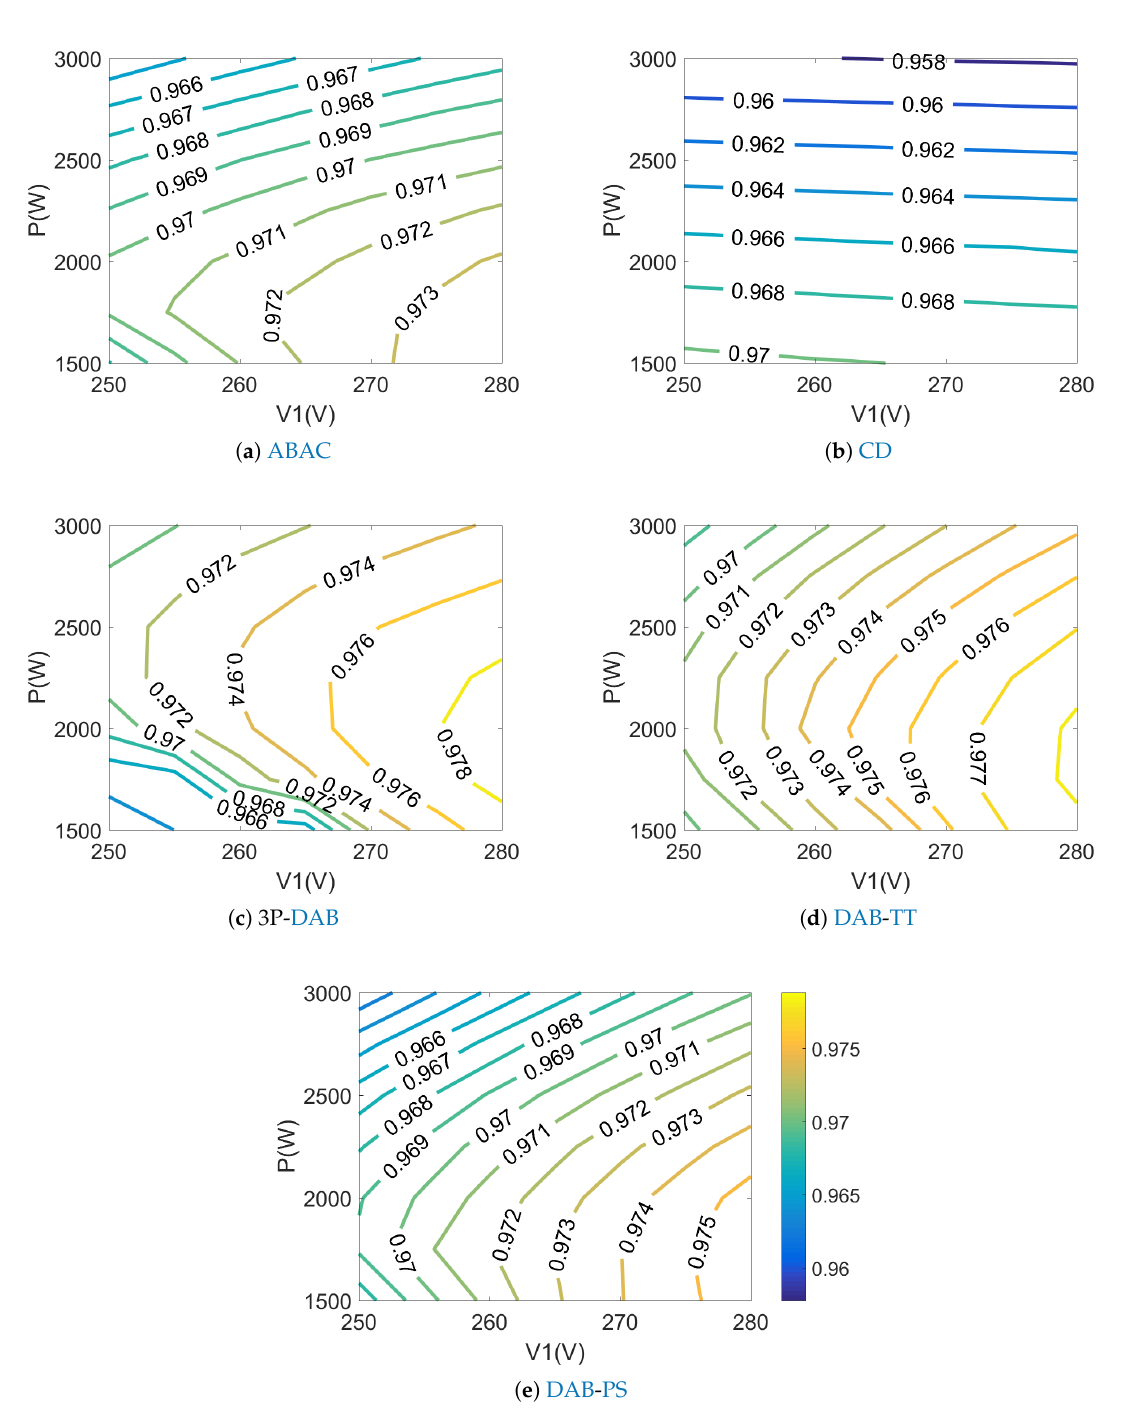
Figure 9. Efficiency map in buck mode, from half power to full power, wide V1 input range, and nominal